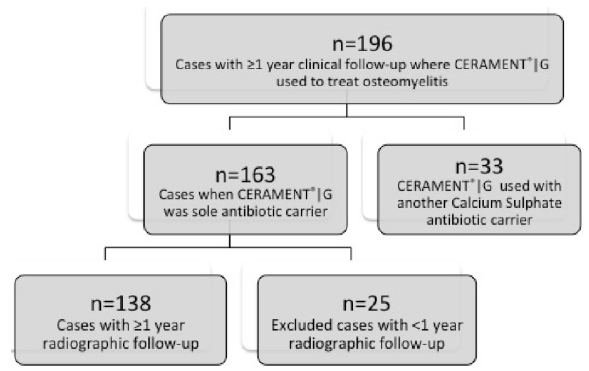
Figure 1. Flowchart demonstrating excluded cases.